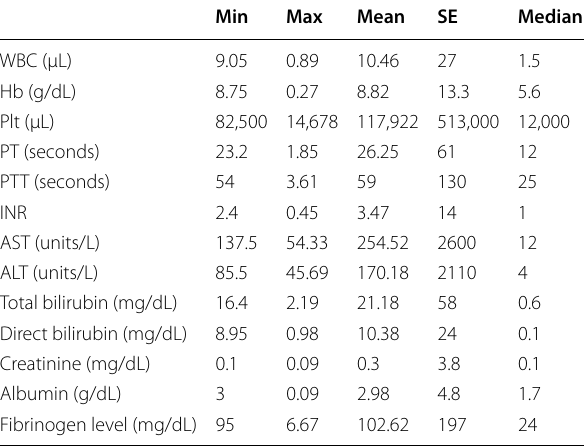
Table 2 Descriptive study of various laboratory parameters in children